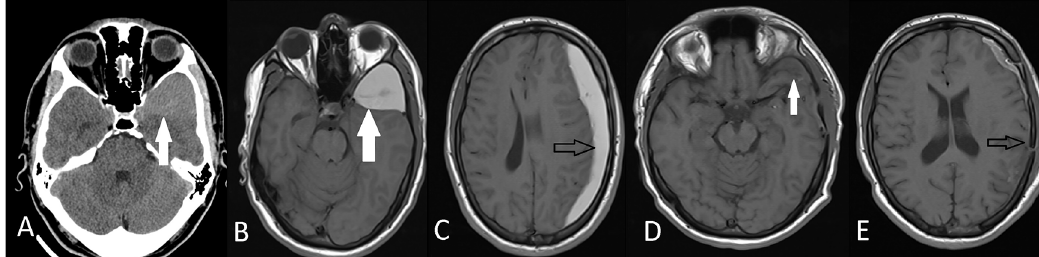
Figure 3. Preoperative axial CT (A) and axial T1W MRI (B) images show left middle fossa arachnoid cyst (white arrows)ofCase6. AxialT1WMRI(C)showsipsilateralsubduralhematoma(blackarrows).PostoperativeaxialT1WMRI (D,E) demonstrates that the hematoma and the arachnoid cyst was evacuated with a tiny fluid in the subdural place.